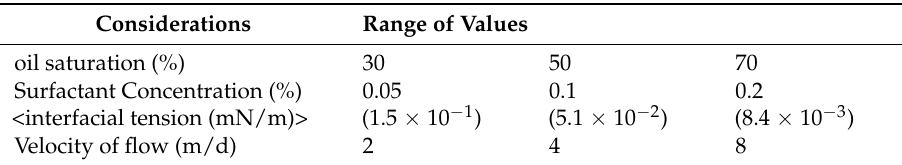
Table 6. Orthogonal test parameters of drag coefficient.